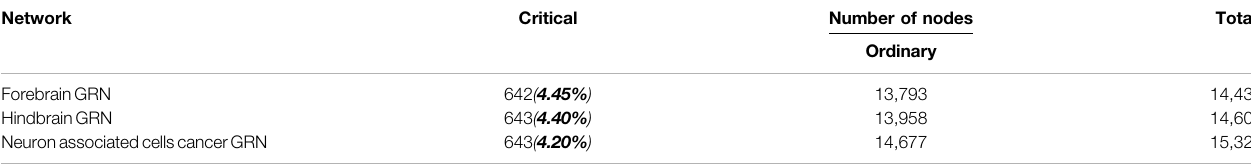
TABLE 1 | Classi fi cation by driver nodes. Network Critical